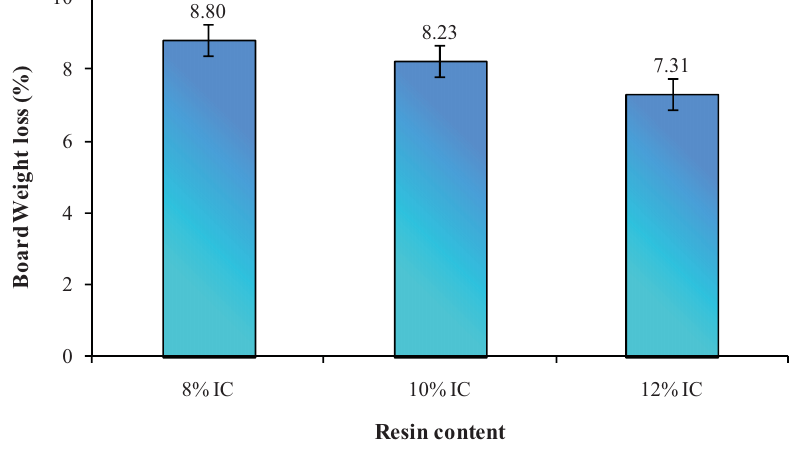
Figure 1. Mean mass loss in percentage of bare sisal fiberboards at three levels of isocyanate